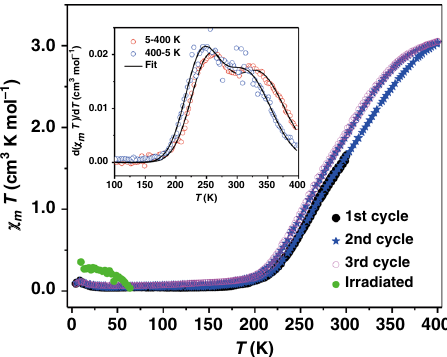
Fig. 2 Magnetic properties of 1·0.5EtOH. Temperature-dependent χ m T product and light-induced valence tautomerism effect induced by laser. The measurement was performed with a sweeping rate of 5Kmin − 1 in a 5 – 300 – 5 ( fi rst cycle) – 400 – 5 (second cycle) – 400 – 5K (third cycle) sequence. Inset: fi rst-order derivatives of the χ m T product and double Gaussian fi tting (black lines) in the second measurement cycle (5 – 400 –